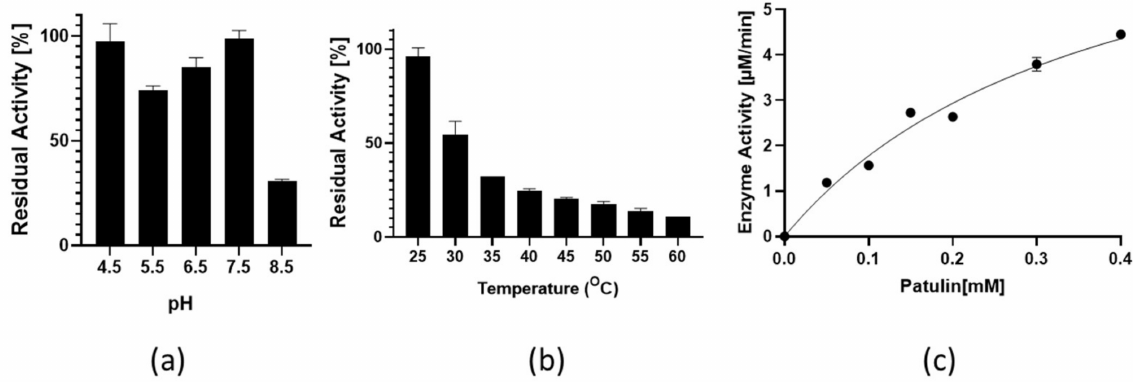
Figure 4. Biochemical characterization of P. expansum newly identified enzyme (PELa). The activity of recombinantly expressed and purified PELa from P. expansum was tested at different pH levels ( a ) and different temperatures ( b ). Error bars indicate standard deviation of three replicates for each treatment. ( c ) Michaelis–Menten kinetics analysis with 0.6 µ M of fungal lactonase in activity buffer, 100 mM Tris-HCl pH 7.5, 100 mM M NaCl, and 100 µ M ZnCl 2, and 0–0.4 mM patulin in activity buffer pH 7.5, at 25 ◦